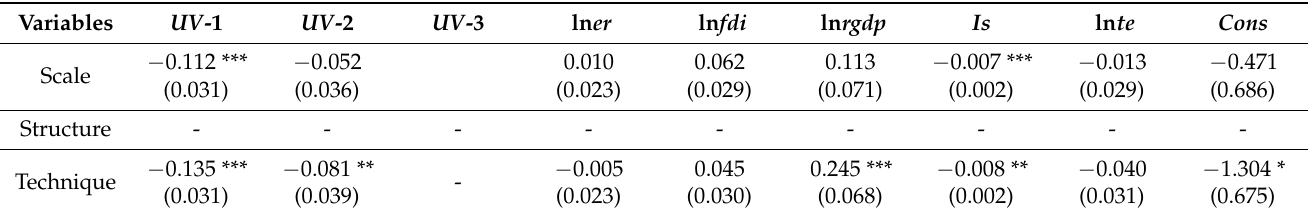
Table 5. Regression results of the threshold effect of unrelated variety of knowledge on the variables of urban green innovation